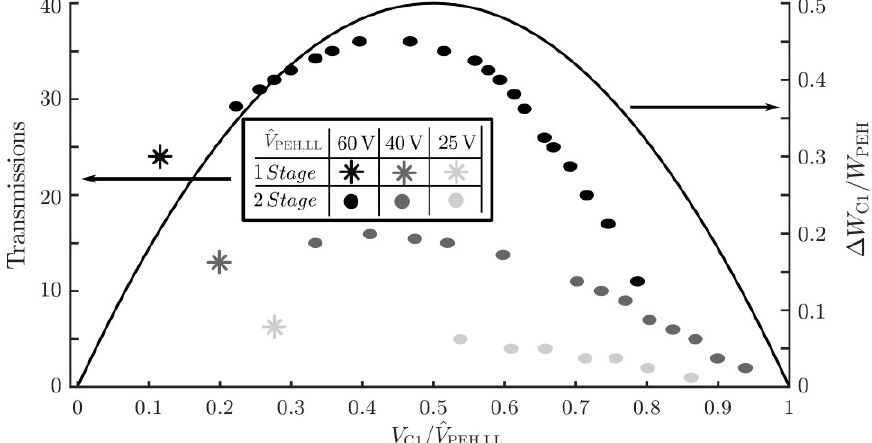
Figure 4. Evaluation of the energy harvester (Figure 1) and the proposed two-stage energy extraction circuit (Figure 3). The right y-axis data shows the theoretical energy extraction rate. The left y-axis data compares the absolute measured number of sent radio transmissions for the single-stage and the two- stage approach, varying excitation and (cid:1848) C1 / (cid:1848) PEH,LL